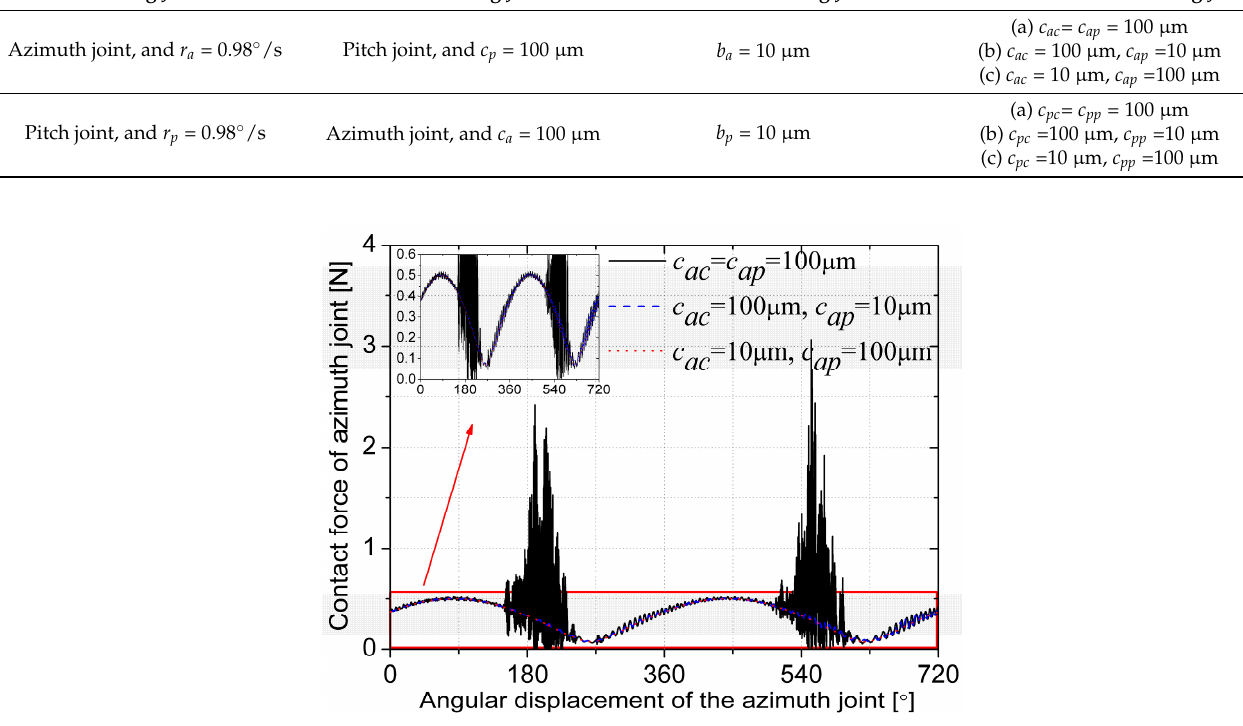
Figure 7. The radial contact force of azimuth joint with different radial clearance.